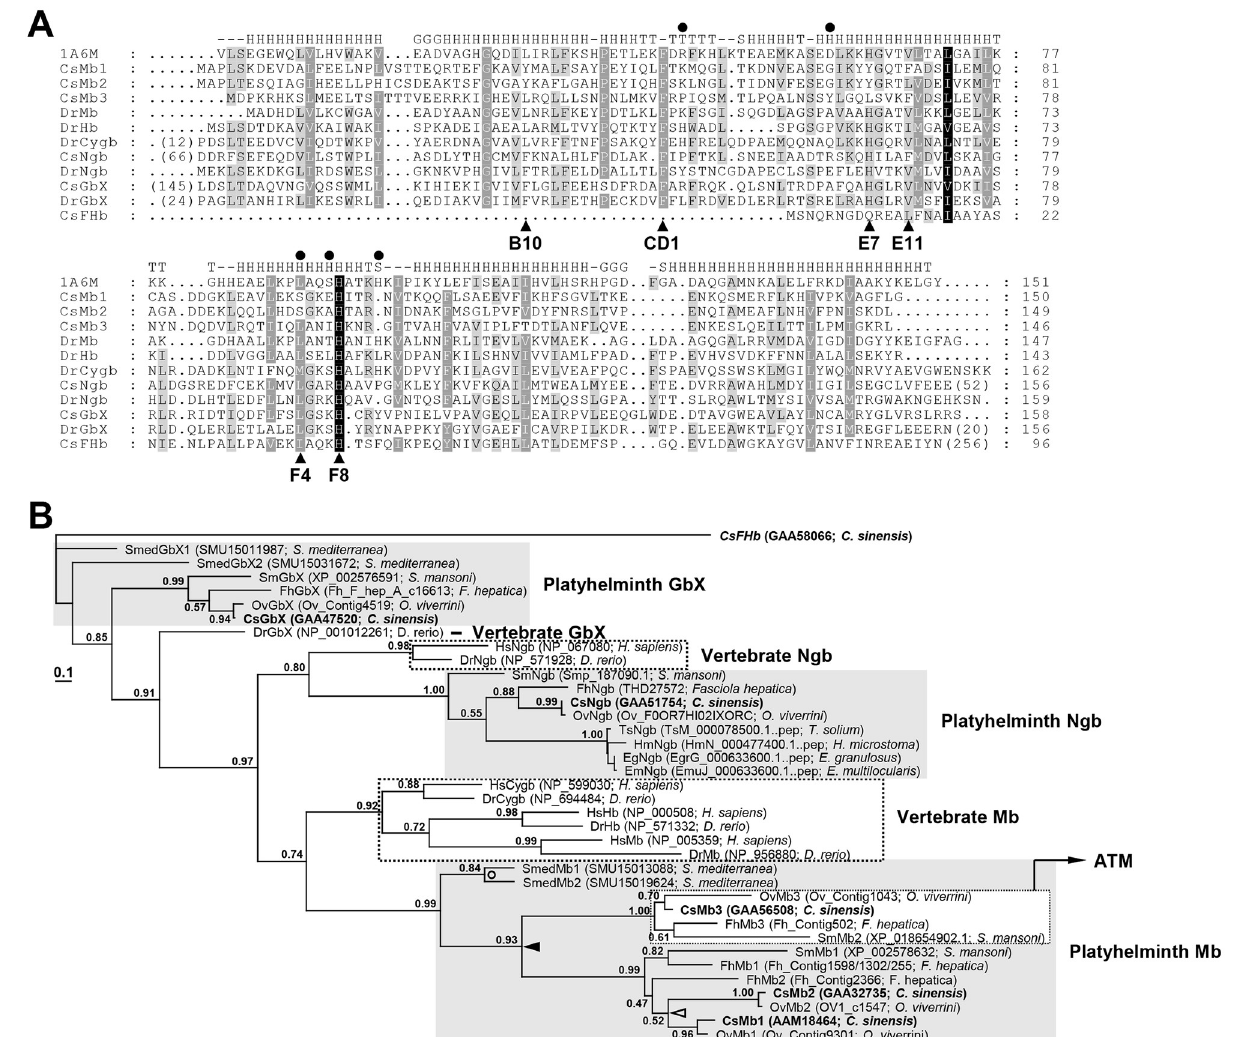
Fig 1. Structural features of the Clonorchis sinensis globins. A. The amino acid sequences of the C . sinensis proteins were aligned with those of Physeter catodon , of which the tertiary structure was empirically determined (PDB no. 1A6M), and Danio rerio orthologs. The degree of amino acid conservations was highlighted by different shades of grey, and gaps were introduced in the alignment to increase the similarity values. The amino acid positions involved in the binding of heme and oxygen molecules are marked with solid arrowheads and circles (see text). Secondary structure elements determined in the P . catodon globin are shown on the top of the alignment (-, no secondary structure assigned; S, bend; T, turn; G, 3/10-helix; H, alpha- helix). B. A phylogenetic tree of C . sinensis globins and their orthologs. The maximum likelihood tree was constructed using PhyML based on the sequence alignment of globin domains and was rooted in CsFbH. C . sinensis proteins are highlighted in boldface. Branch support values > 0.50, which were obtained by the Shimodaira-Hasegawa-like approximate likelihood ratio test, are indicated at the corresponding branching nodes. The solid arrowhead indicates an evolutionary point where the progenitor of the platyhelminth Mb gene might have been duplicated.